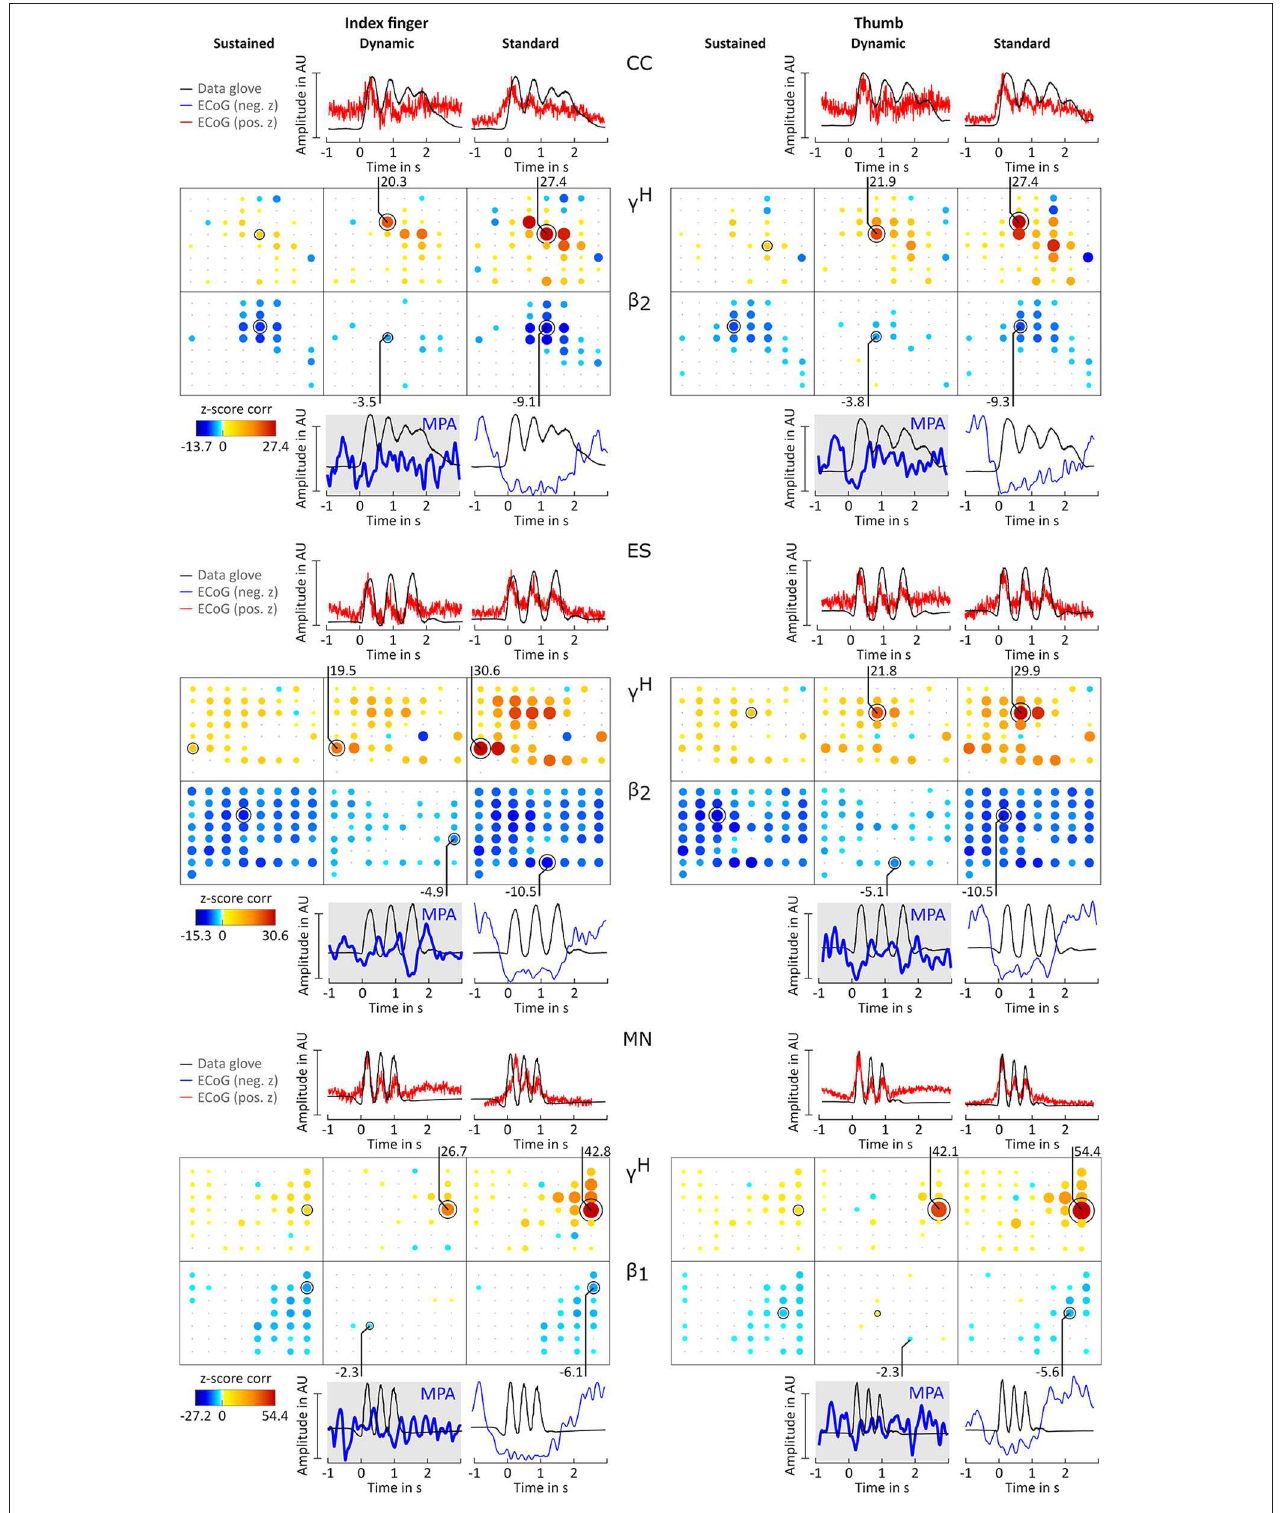
FIGURE 4 | Correlation analysis results and MPA for subjects CC, ES, and MN. Significant z-score transformed Pearson correlation coefficients for each channel, topographically arranged in bubble plots, for index finger (left) and thumb (right) are displayed. For each subject all conditions (columns, sustained, dynamic, and standard) of γ H = 70 − 150 Hz and the sub-band β 1 = 12 − 18 Hz or β 2 = 18 − 24 Hz with the highest significant z-scores are displayed. Bubble size and color is not directly comparable from subject to subject due to different color-bar ranges. For more detailed description see Figure 3 .